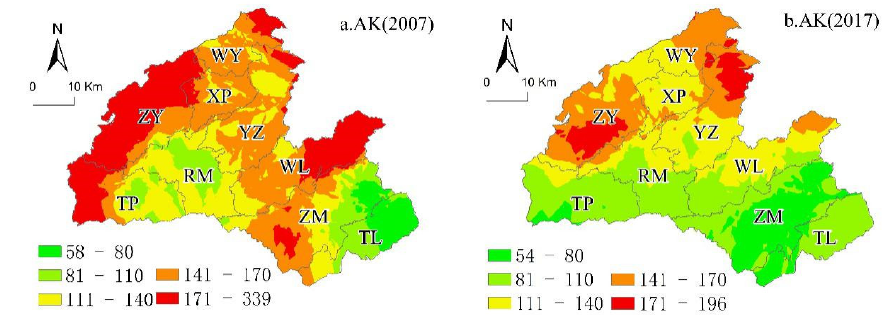
Figure 7. Ordinary kriging distribution maps for ( a ) 2007 AK and ( b ) 2017 AK. (4) Spatial Distribution of Soil pH in 2007 and 2017 In 2007, approximately 1.9%, 17.35%, 50.37%, and 27.95% of the samples were ex- tremely acidic, very acidic, acidic, slight acidic, or neutrality, respectively, and 5.38% of the land was neutral. In 2007, the land proportion decreased by −1.03%, −16.17%, −37.58% at extremely acidic, very acidic, and acidic conditions, respectively, and the land propor- tion increased by 8.75% and 46.02% at slightly acidic conditions and neutrality, respec- tively. The CV for soil pH in Hefeng County had moderate variability (15.87% in 2007, 12.88 in 2017; Table 3). The distribution of soil pH levels in Hefeng County was generally acidic, with pH levels at a neutral level in the southeast, north, and southwest in 2007 (Figure 8a). In 2017, 51.40% of the soil pH was at a neutral level, mainly in Zhongyin (ZY), Xiaping (XP), Rongmei (RM), and Zouma (ZM); 34.46% of the soil was weakly acidic. Soil below pH 5.5 was located in the northeastern part of Zhongyin (ZY), and the land of soil pH below 5.5 decreased from 50.37% of the total area in 2007 to 12.79% of the total area in 2017 (Figure 8b).